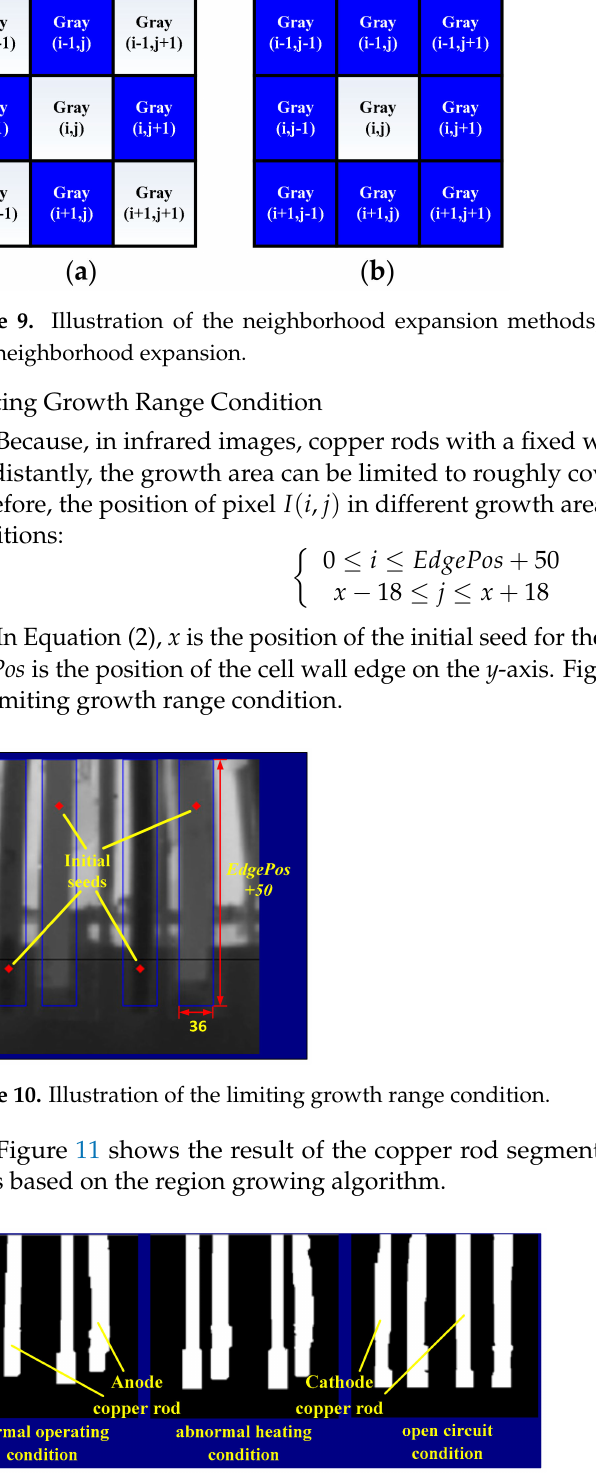
Figure 11. Results of the copper rod segmentation based on the region growing